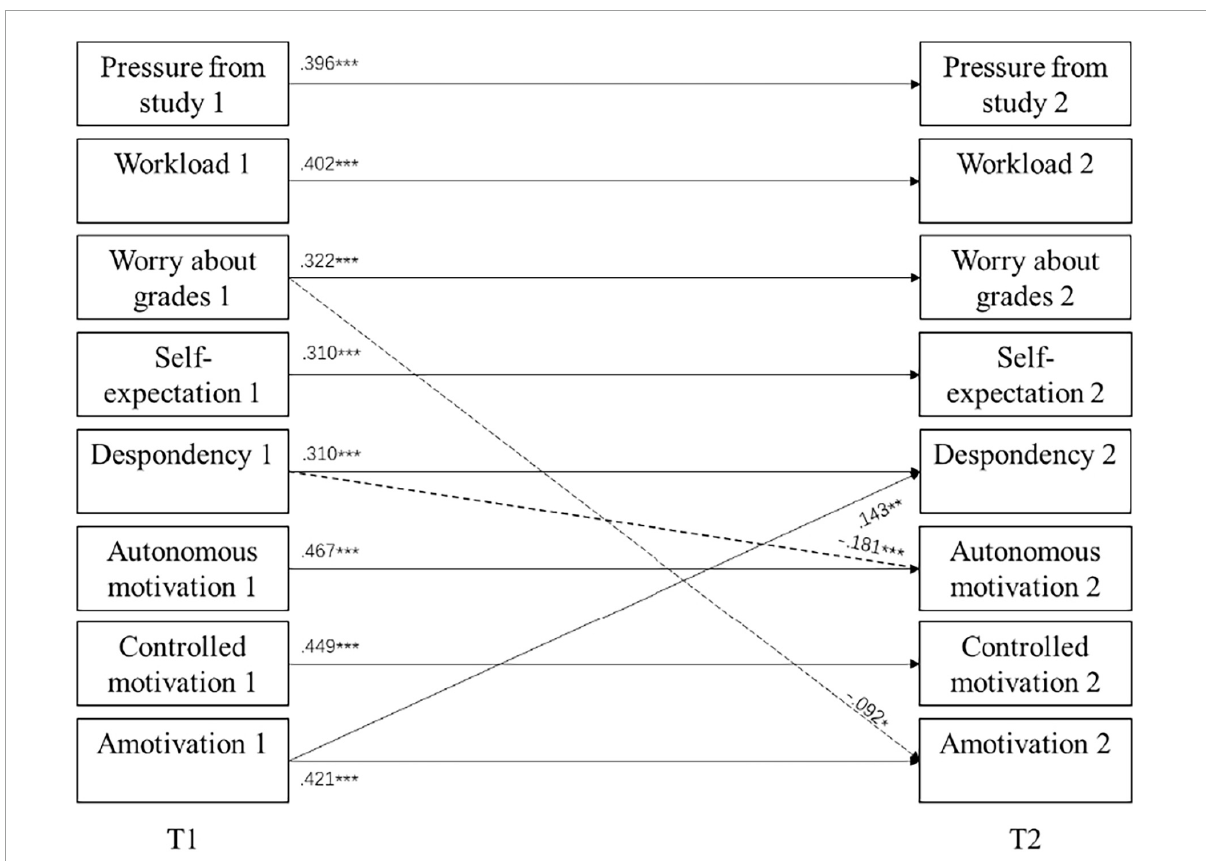
FIGURE1 Cross-lagged model of the relationship between academic stress and motivation toward physical education (PE). Dashed lines depict the negative regression. * p < 0.05; ** p < 0.01; *** p <